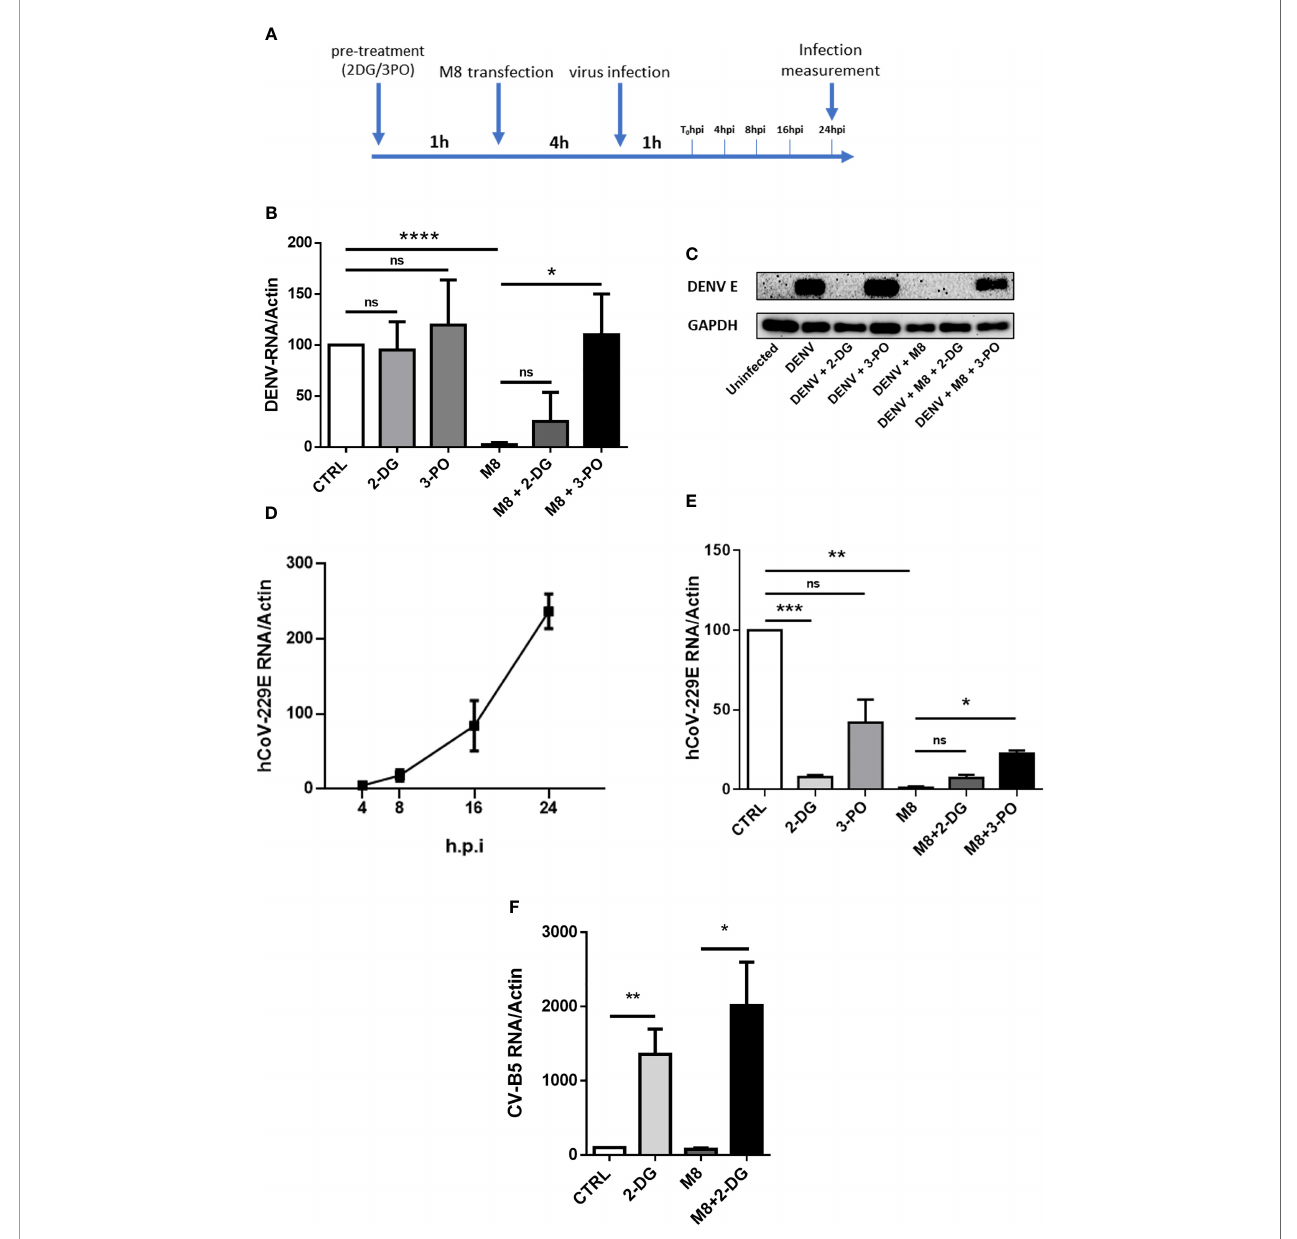
FIGURE 5 | M8 requires glycolysis to exert its antiviral effect in monocyte-derived dendritic cells (MoDCs). (A) Schematic timeline representation of hCoV-229E and dengue virus (DENV) infection of human primary MoDCs. Previous stimuli were not removed when a new factor was added to cells. (B) quantitative polymerase chain reaction (qPCR) analysis of DENV RNA expression: MoDCs were treated with 2-deoxyglucose (2-DG) (7mM) or 3-PO (25 µM) for 1h and then transfected with M8 (0.5 ng/ml). After 4h cells were infected with DENV (MOI 5) for additional 24h. Cells were then harvested and expression of viral RNA was assessed by qPCR. DENV RNA expression was normalized on b -actin and results represent fold changes compared with CTRL (DENV alone), set as 100. (C) Immunoblot analysis representative of DENV E Protein expression in different samples. MoDCs were treated as in (B) then protein expression was analyzed by Western blot and viral protein expression was normalized on endogenous GAPDH. (D) qPCR analysis of hCoV-229E RNA expression. In order to assess viral replication, MoDCs were infected with human coronavirus 229E (MOI 1), cells were harvested at the indicated time points and viral RNA levels were measured by qPCR and normalized on b - actin. (E) MoDCs were treated with 2-DG (7 mM) or 3-PO (25 µM) for 1h and then transfected with M8 (0.5 ng/ml). After 4h cells were infected with hCoV-229E (MOI 1) for 24h. Cells were then harvested, and expression of viral RNA was assessed by qPCR. 229E RNA expression was normalized on b -actin and results represent fold changes compared to CTRL (hCoV-229E alone), set as 100. (F) MoDCs were treated with 2-DG (7 mM) for 1h and then transfected with M8 (0.5 ng/ml). After 4h cells were infected with Coxsackie virus B5 (CV-B5) (MOI 1) for 24h. Cells were then harvested, and expression of viral RNA was assessed by qPCR. CV-B5 RNA expression was normalized on b -actin and results represent fold changes compared with CTRL (CV-B5 alone), set as